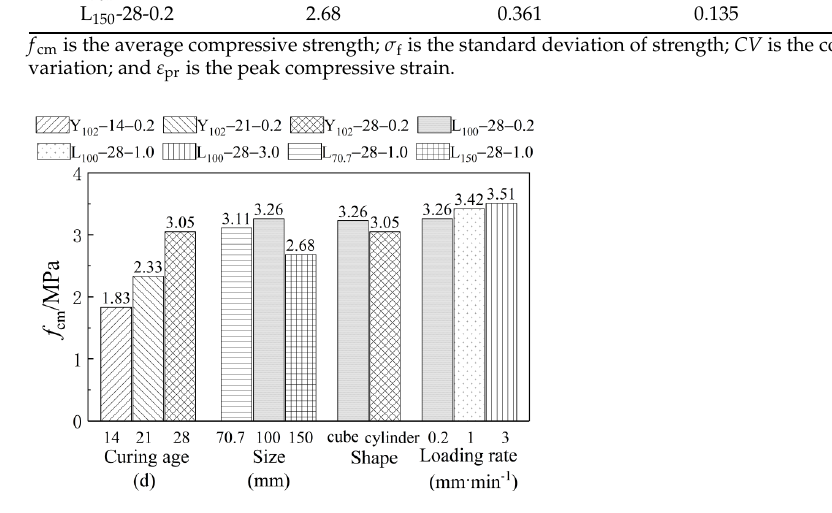
Figure 8. Comparative diagram of compressive strength of specimens under different working con- Figure 8. ditions.